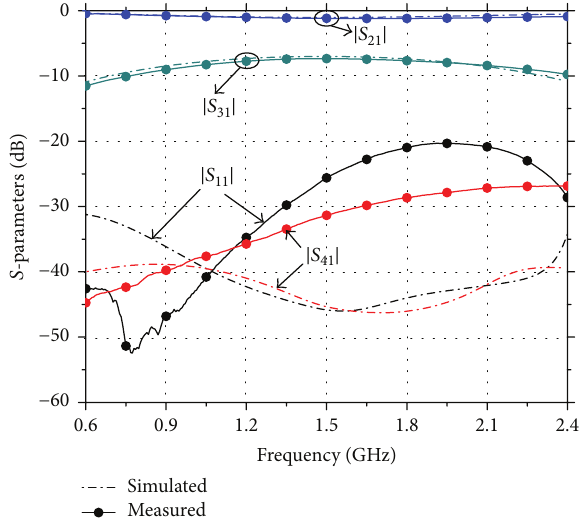
Figure 6: Simulated and measured 𝑆 -parameters of the 7 dB coupler configured with the PCMLFGPC.